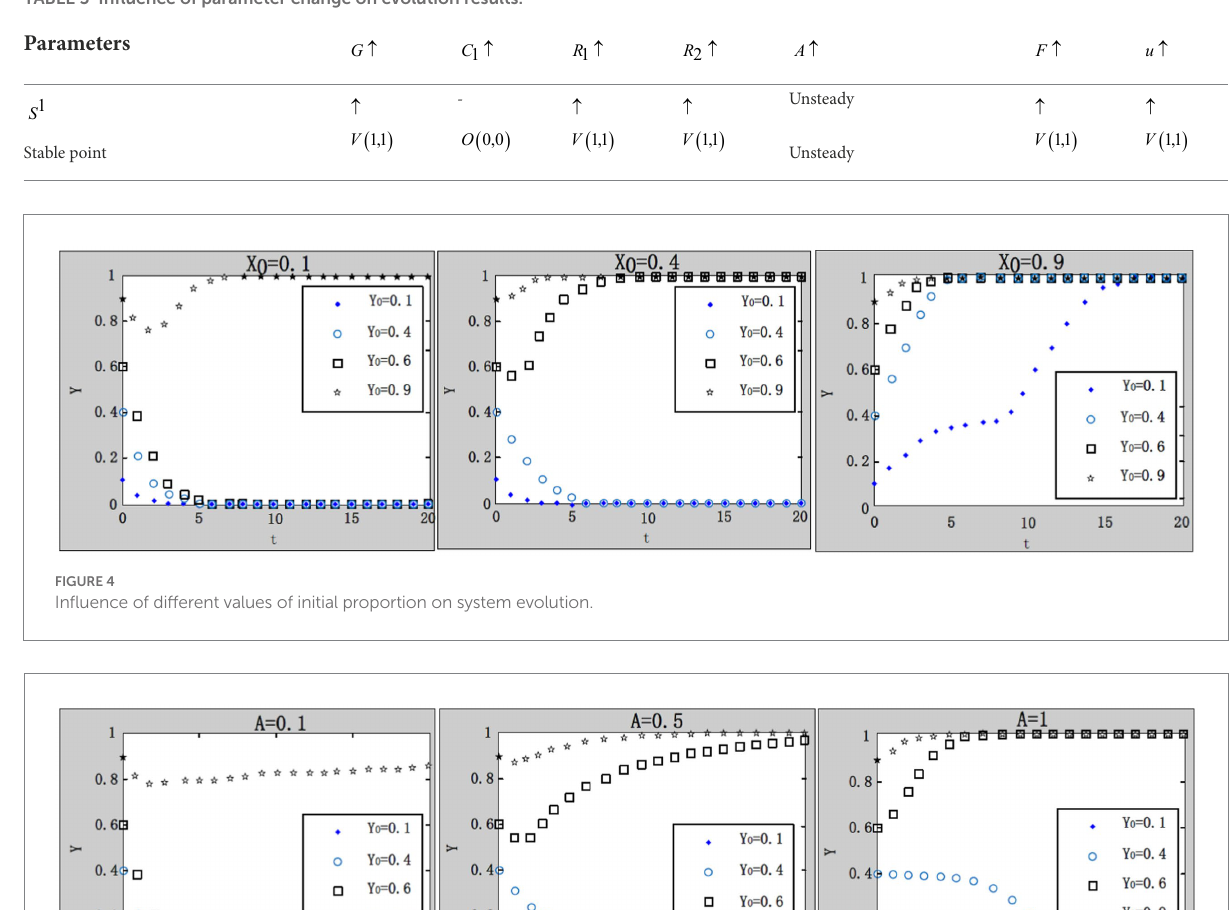
TABLE 5 Influence of parameter change on evolution